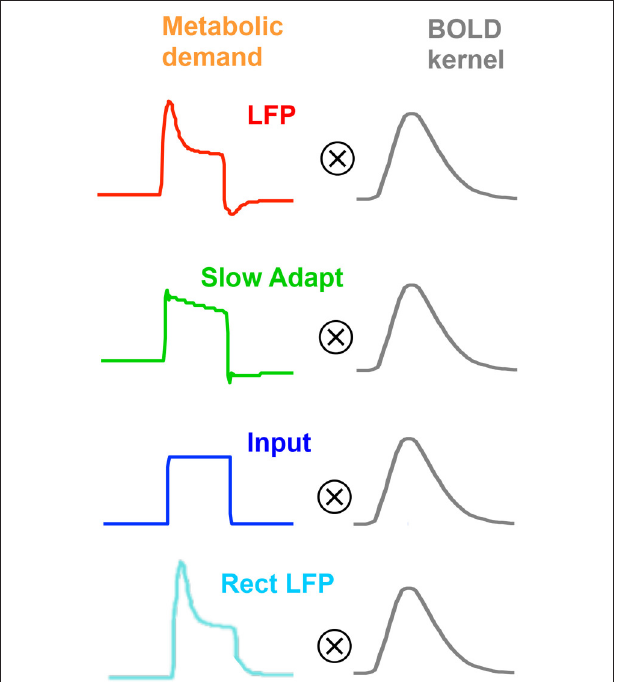
FIGURE 5 | Four plausible models of the BOLD response characteristic through linear convolution with various metabolic response kernel